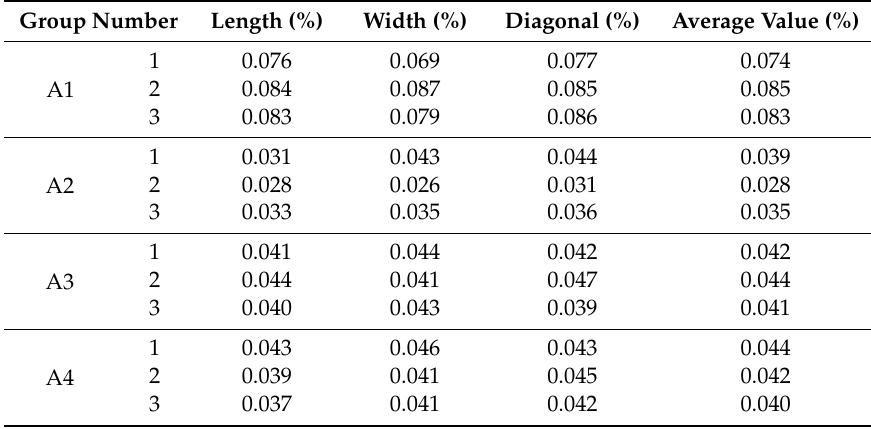
Table 4. Warp degree of veneered RSP with di ff erent